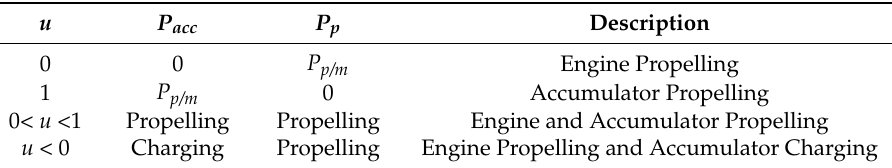
Table 2. Power-splitting factor and power flows